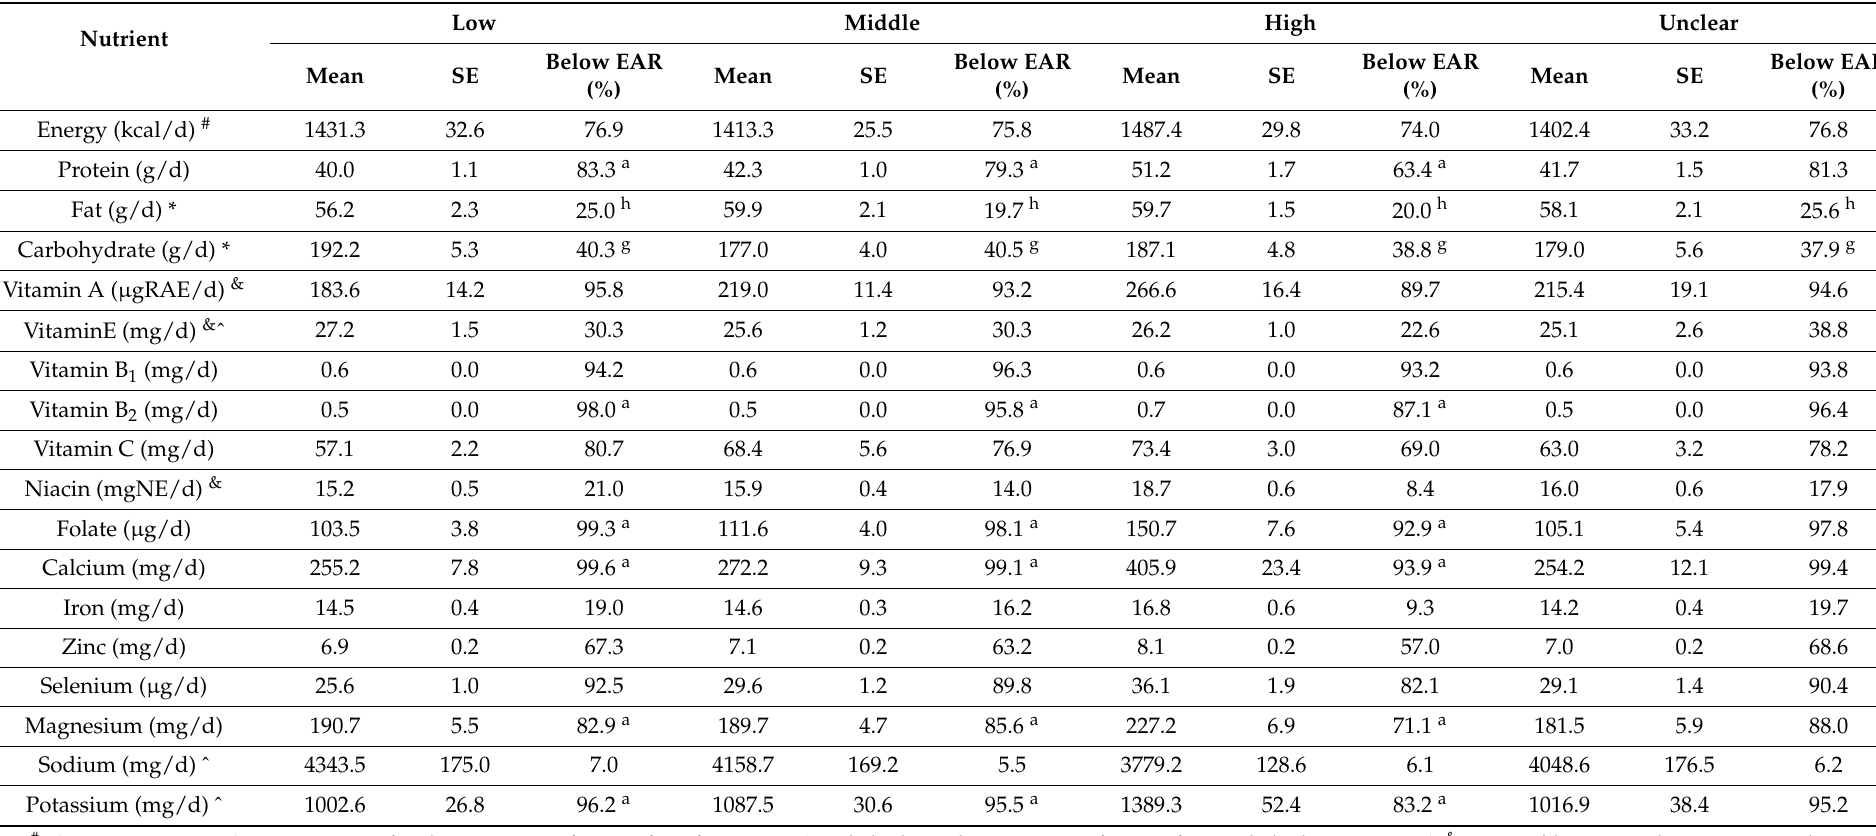
Table 7. Dietary daily intake of energy and nutrients intakes and the prevalence of deficiency in the subjects aged 80 and above in different household income level. Low Middle High Unclear Nutrient Below EAR Below EAR Below EAR Below EAR Mean SE Mean SE Mean SE Mean SE (%) (%) (%) (%)